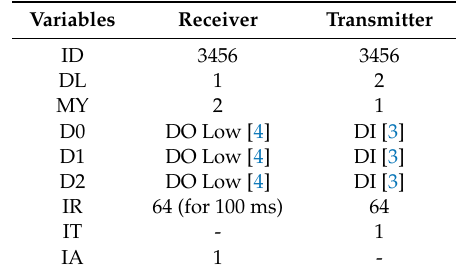
inputs or outputs; IR is the sample